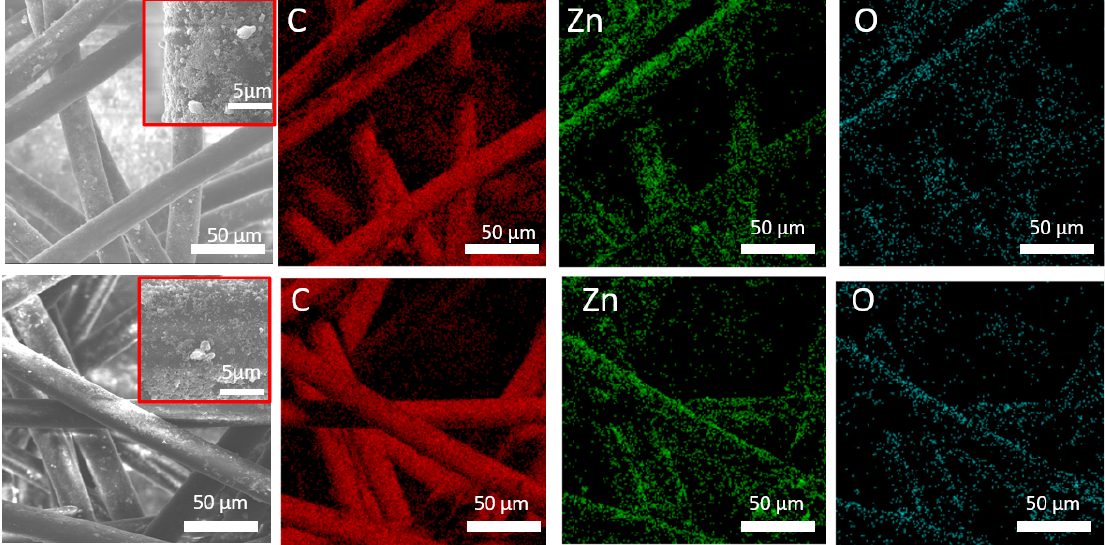
Figure 2. SEM images and corresponding EDXS elemental maps of PCL-ZnO and PCL-ZnO-24 h samples. Table 1. Sample atomic compositions measured by EDXS.